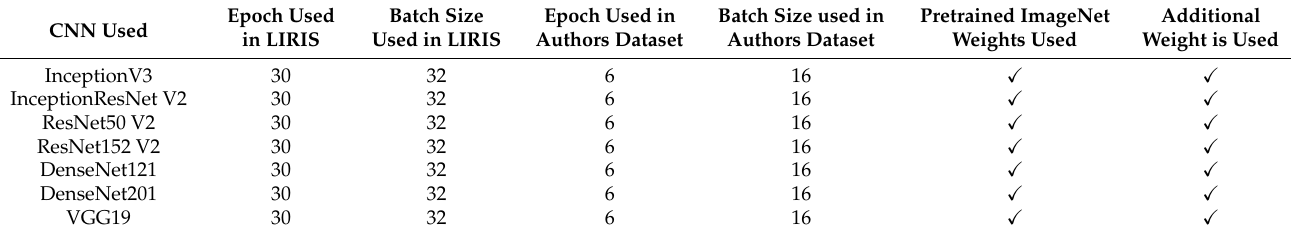
Table 7. Final hyperparameters of experimental models.